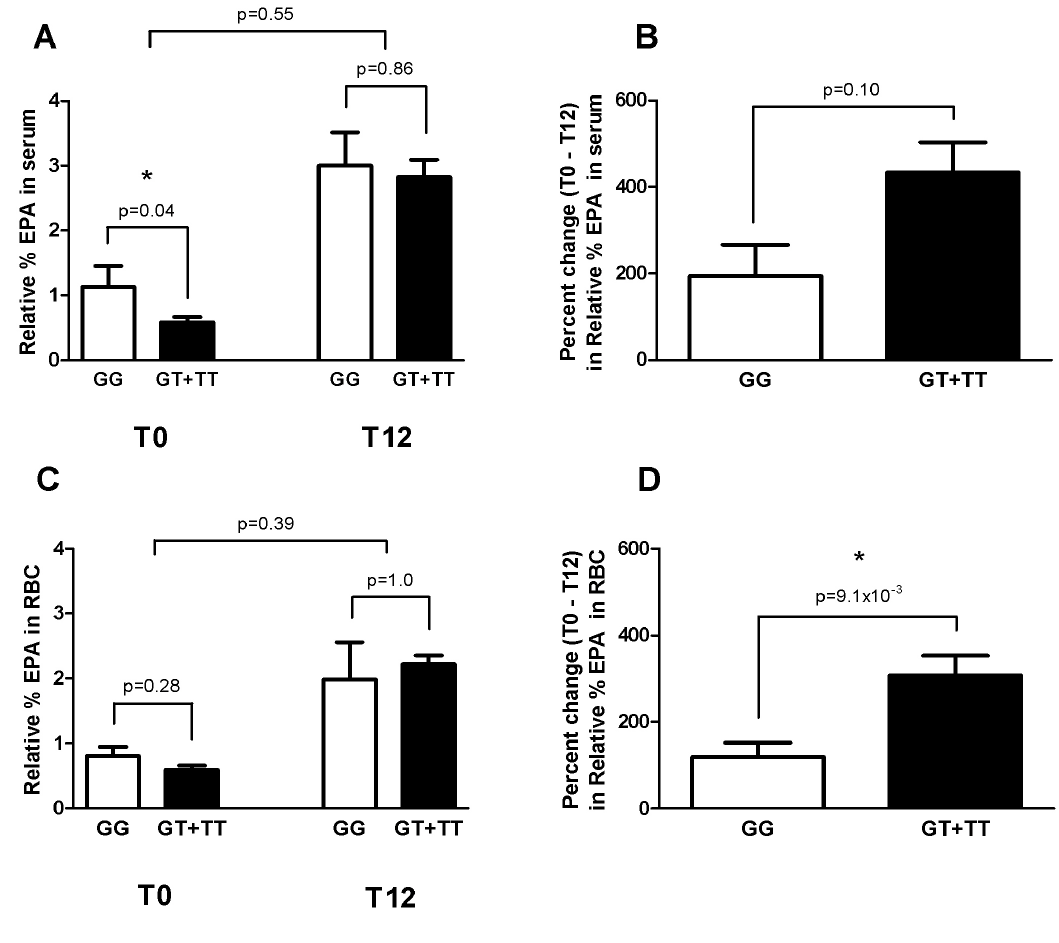
Figure 3. Eicosapentaenoic acid (EPA) levels in major and minor allele carriers of the rs174537 SNP in FADS1. ( A ) Differences in relative % EPA in serum between major and minor allele carriers at both baseline (T0) and week 12 (T12) as well as the interaction between genotype × time. ( B ) Percent changes ( i.e. , T0 − T12) for serum % EPA in major and minor allele carriers. ( C ) Differences in relative % EPA in RBCs between major and minor allele carriers at both T0 and T12 as well as the interaction between genotype × time. ( D ) Percent change ( i.e. , T0 − T12) for RBC % EPA in major and minor allele carriers. p -Values are listed above each of the comparisons. Major allele carriers (GG) ( n = 3) and minor allele carriers (GT + TT) ( n = 9). * Indicates p <